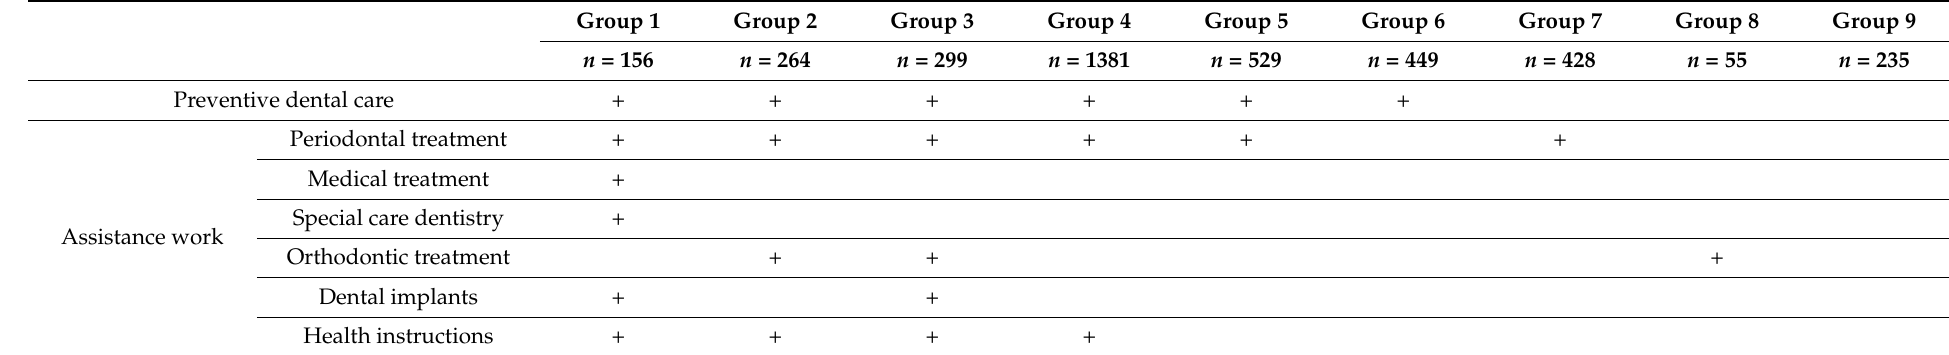
Table 1. Characteristics of the groups by tSNE